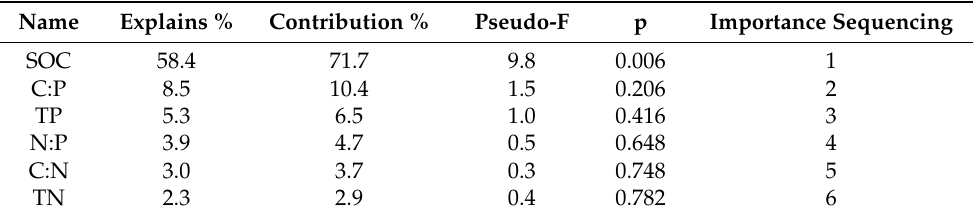
Table 4. Significance order and significance level test of soil organic carbon (SOC), total nitrogen (TN), total phosphorus (TP), and soil stoichiometric characteristic